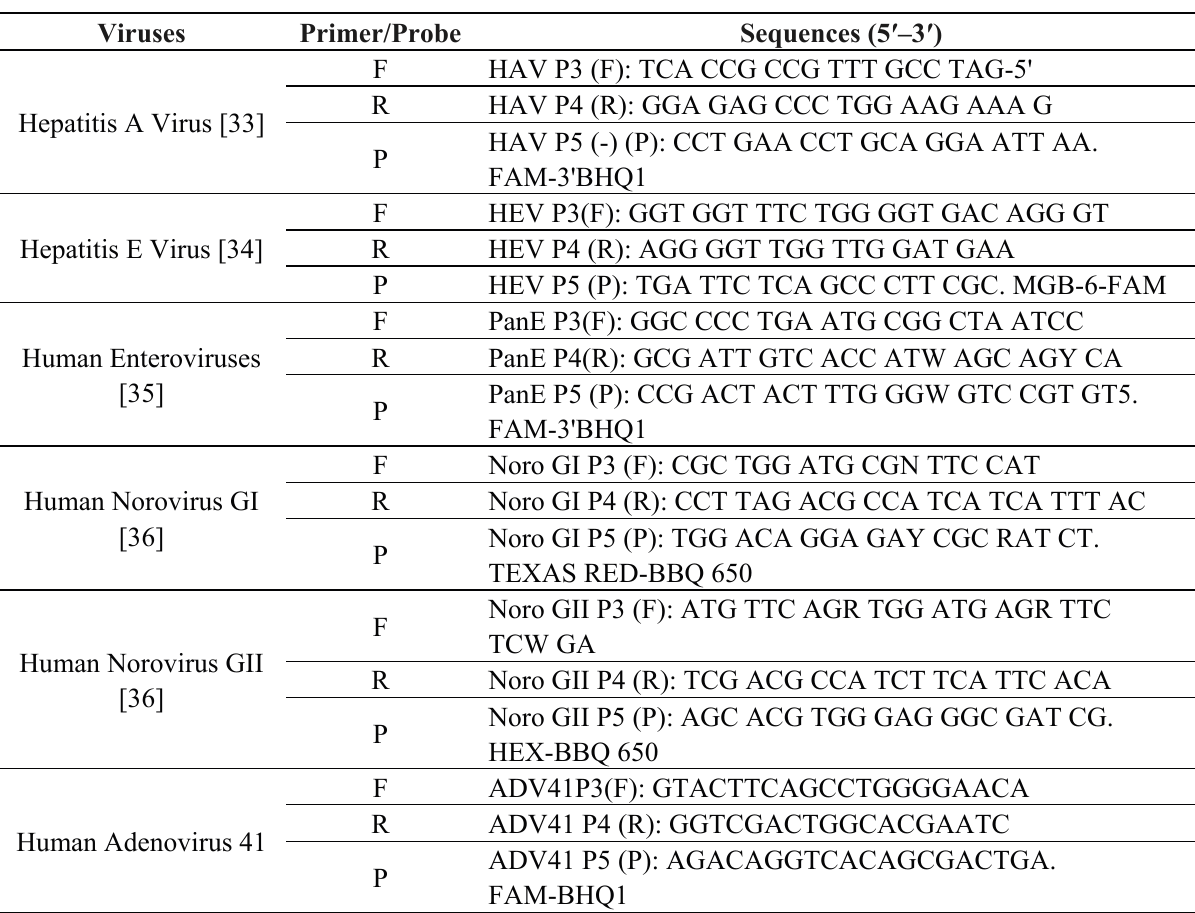
Table 1. Sequences of primers used to detect viruses in water by q-PCR assays (Human Enterovirus: HE; Hepatitis A Virus: HAV; Norovirus GGI: NoGGI; Norovirus GGII: NoGGI; Hepatitis E Virus: HEV; Adenovirus 41: ADV41. Abbreviations: FAM, 6-carboxyfluorescein reporter dye; BBQ650, Black Berry Quencher 650; BHQ1, Black Hole Quencher.